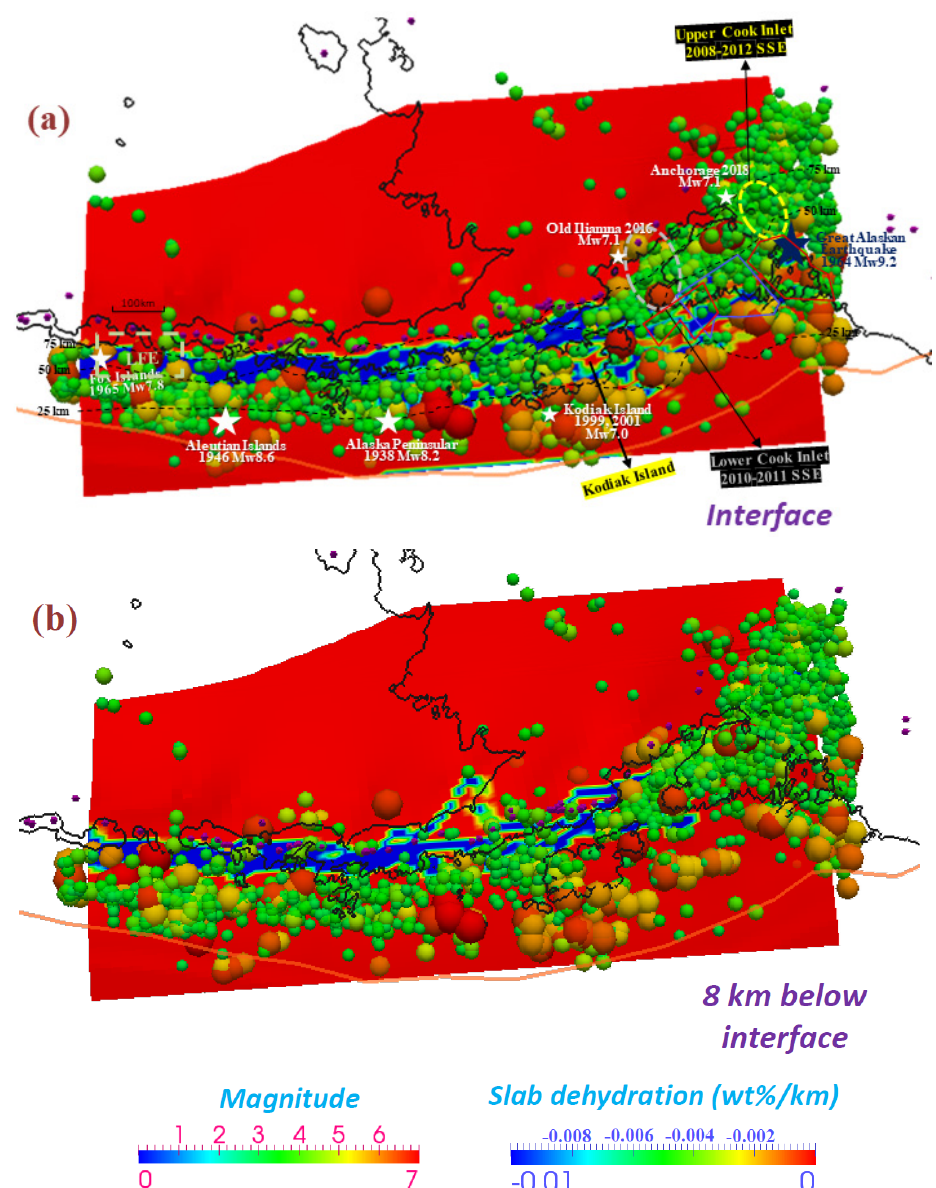
Figure 5. Slab water content (wt%) was calculated at depths of ( a ) 0 (subduction interface) and ( b ) 8 km vertically below the interface. The black dashed lines represent the isodepth contours of 25, 50, and 75 km. The yellow and gray dashed circles represent the slow slip event patches in the Upper Cook (2008–2012, [17]) and Lower Cook Inlets (2010–2011, [18]). The green dashed line indicates low-frequency earthquakes [20]. Bold blue lines indicate the 1992.0–2004.8 (~M 7.8) Slow Slip Event, and bold red lines indicate the 2009.85–2011.81 (~M 7.2) Slow Slip Event [21,22].